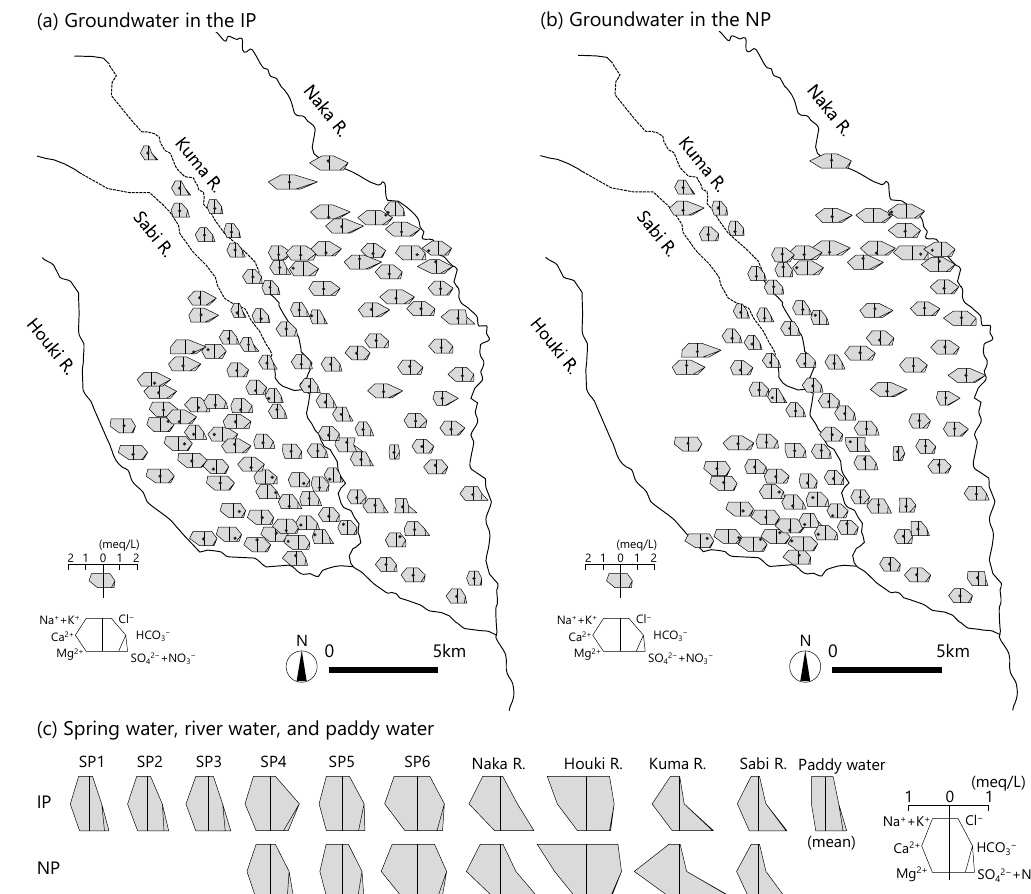
Figure 5. Hexa-diagrams of groundwater, spring water, river water, and paddy water.